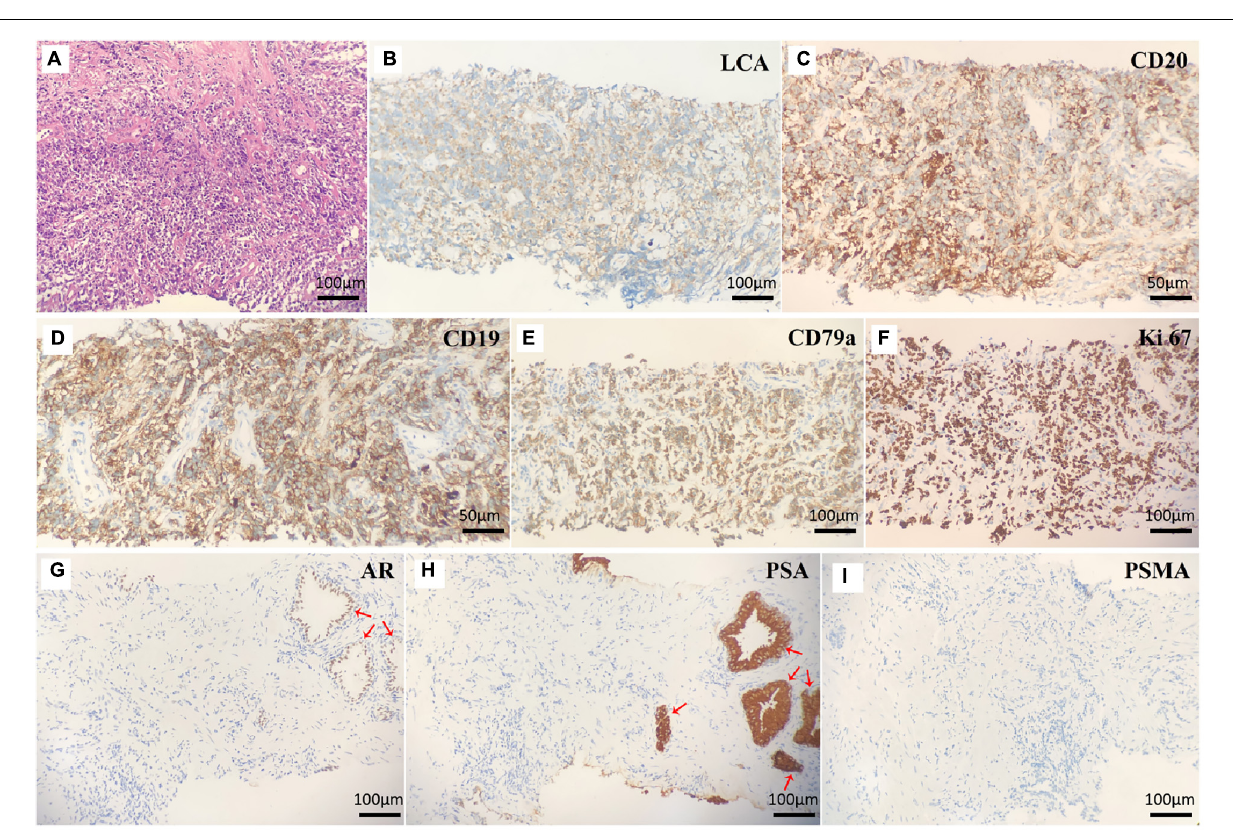
Frontiers in Medicine |